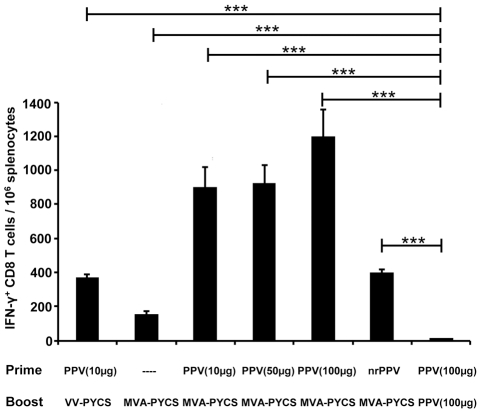
Booster with replication restricted MVA-PYCS vector triggers strong CS CD8+ T-cell response after priming with PPV-PYCS.Groups of BALB/c mice (5 per group) were immunized s.c with different amounts of PPV-PYCS [PPV(10 µg), PPV(50 µg) PPV(100 µg)], with non-recombinant PPV-VLPs (nrPPV) or with VACV vectors (VV-PYCS or MVA-PYCS) in prime/boost protocols and 14 days after the boost CS-specifc IFN-γ secreting cells for the plasmodial epitope SYVPSAEQI in splenocytes were measured by ELISPOT as described under Materials and Methods. Purified PPV-VLPs without the peptide insert were used as control. The results are expressed as the means of assay triplicates of cultured pooled mouse splenocytes. Statistical values were determined by one-way ANOVA; P values, *P<0.05, **P<0.01, ***P<0.001.